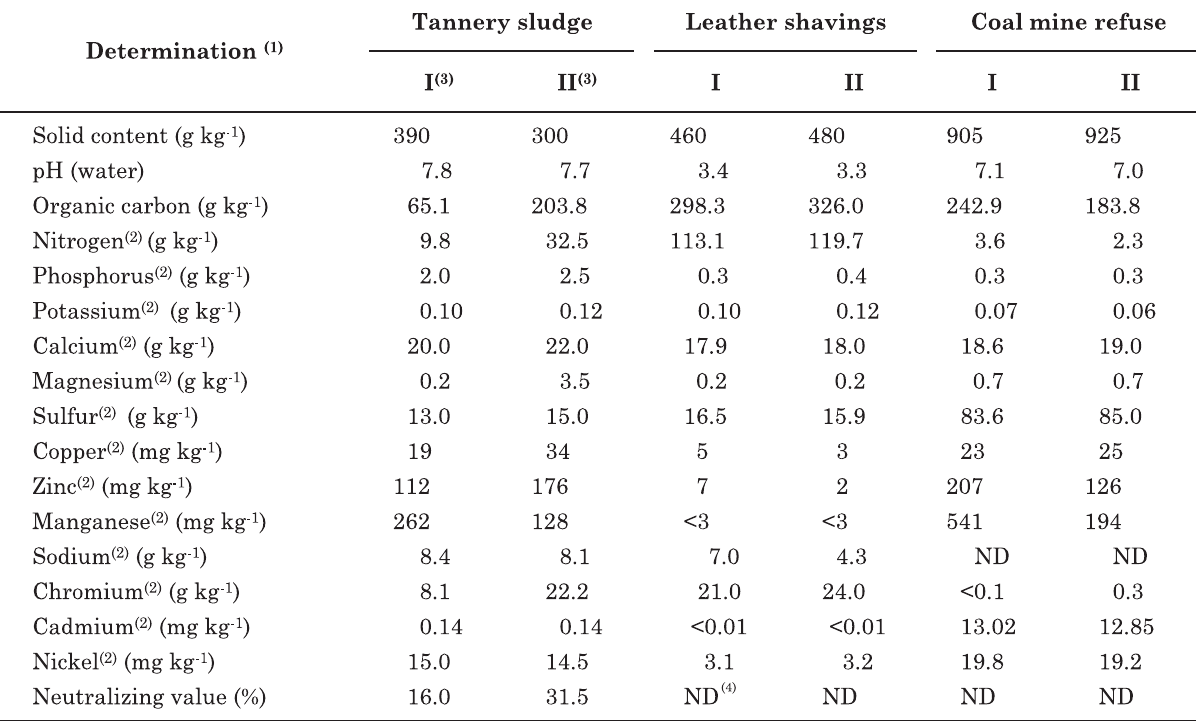
Table 1. Description of the residues applied